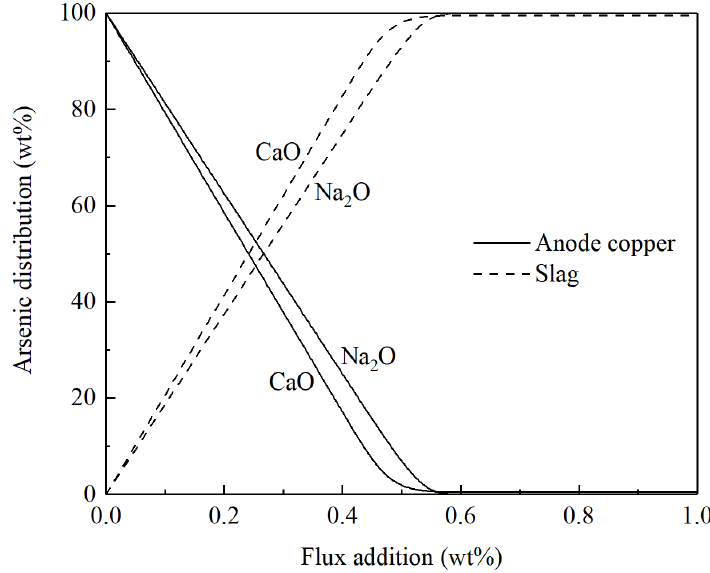
◦ 2 /blister at 1200